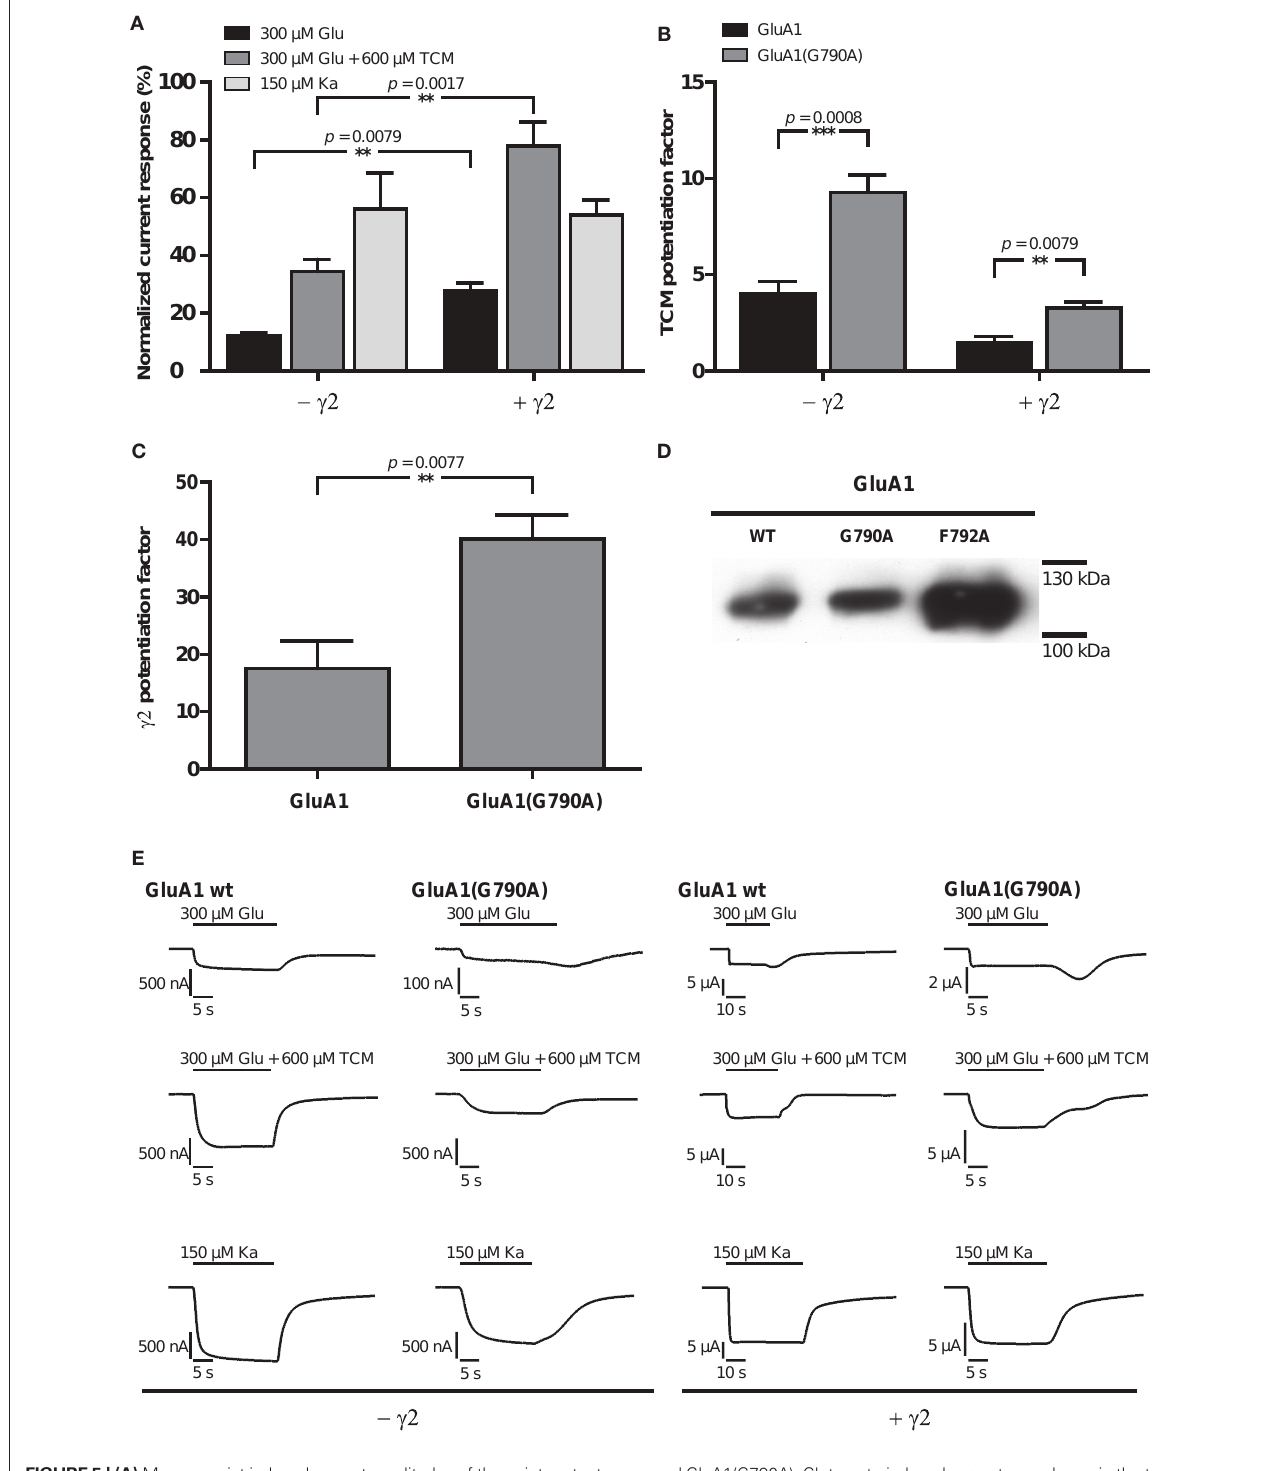
FiguRe 5 | (A) Mean agonist-induced current amplitudes of the point mutant GluA1(G790A) in the absence and presence of γ 2. (B) Potentiation of glutamate-evoked currents by TCM, a desensitization inhibitor. (C) Potentiation of glutamate-induced currents by γ 2. (D) Membrane expression of point mutants of GluA1 wild type. (e) Exemplary current traces of GluA1 wild type